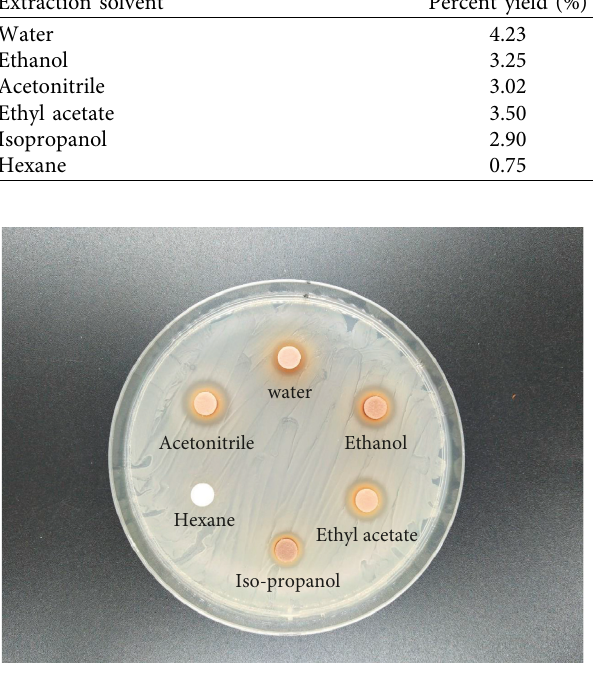
Figure 1: Anti-MRSA screening of A. lakoocha roxb extracts. Table 2: Inhibition zone diameters of A. lakoocha roxb extracts against